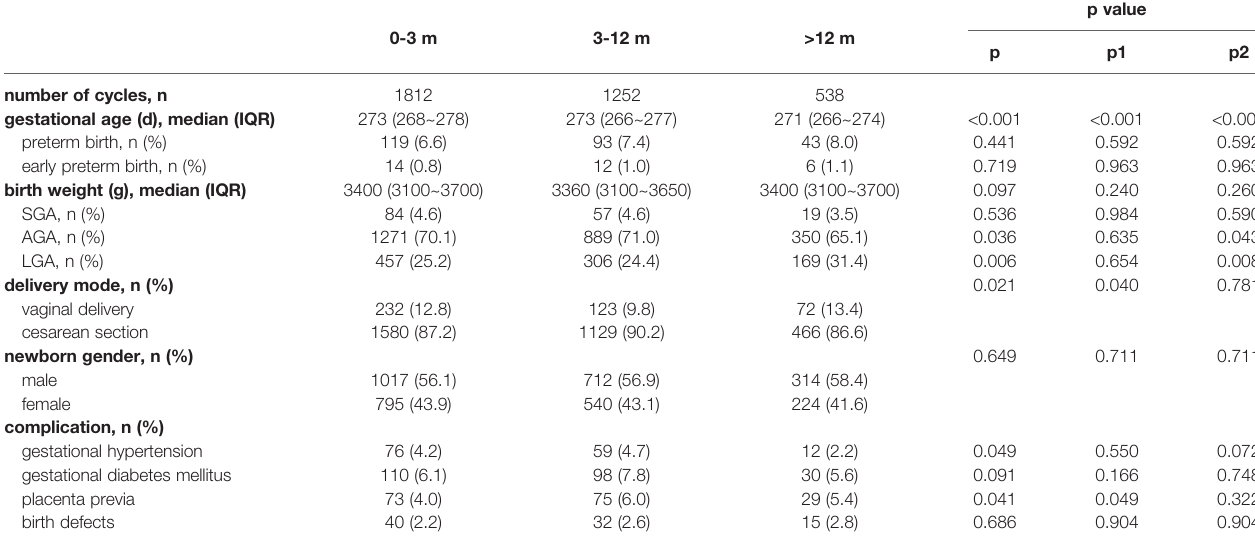
0-3 m 3-12 m >12 m